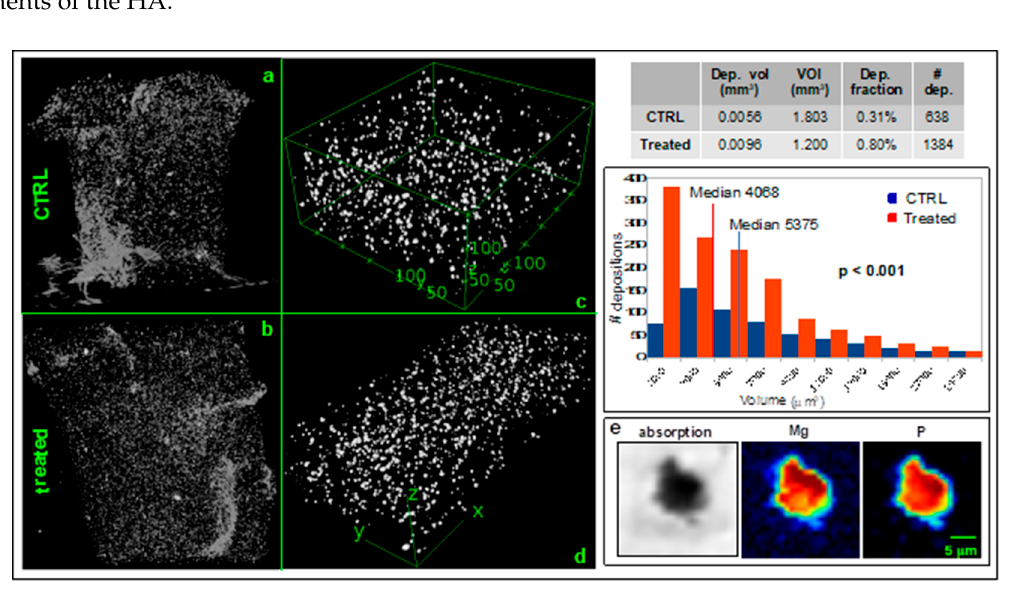
Figure 4. X-ray analysis of depositions released by SaOS2 cells. Panels ( a ) and ( b ) depict the 3D distribution of mineral depositions in the whole control and treated sca ff olds imaged by microfocus X-ray µ CT at the TomoLab station of Elettra (isotropic voxel size = 5 µ m for the control and 3.3 µ m for the treated sample). The dimensions of the sca ff olds are approximately 80 mm 3 . Panel ( c ) and ( d ) show two selected VOIs reporting the depositions distribution in CTRL (6000 × 4300 × 700 µ m 3 ) and treated sca ff olds (7300 × 1200 × 800 µ m 3 ) respectively. Table and graph show the descriptive statistical analysis of the depositions in the two representative VOIs showed in panel c (CTRL) and d (treated), respectively. The graph classified the particles dimension ( µ m 3 ) in relation to the number of particles within the class. Panel ( e ) describes the Mg and P co-localization in a deposition released by a di ff erentiating SaOS2 cell at the TwinMic beamline of Elettra.